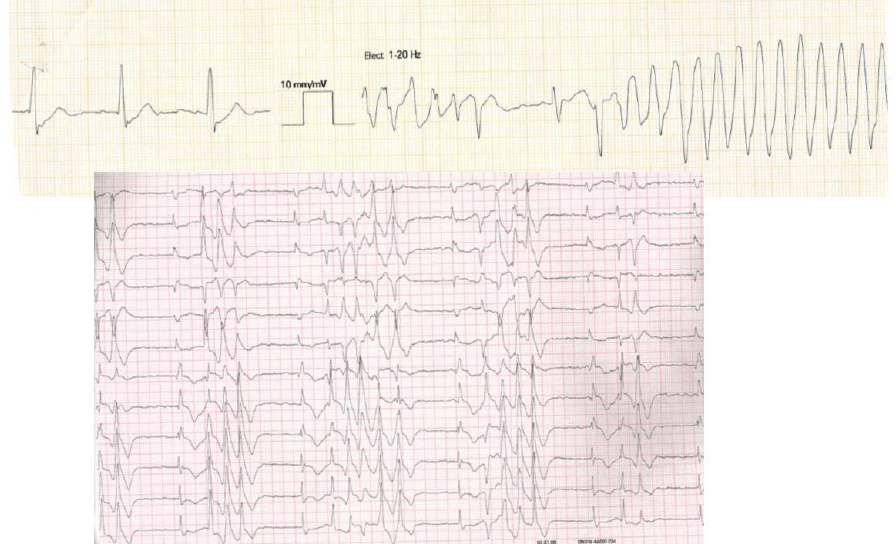
Figure 2. Twelve-lead ECG from an 82-year-old female patient admitted to the emergency department for syncope with brain trauma. The initial ECG shows atrial fibrillation with complete atrioventricular block and ventricular escape rhythm (with right bundle branch block morphology) and salvos of torsades de pointes. The initial episode required urgent electrical cardioversion.